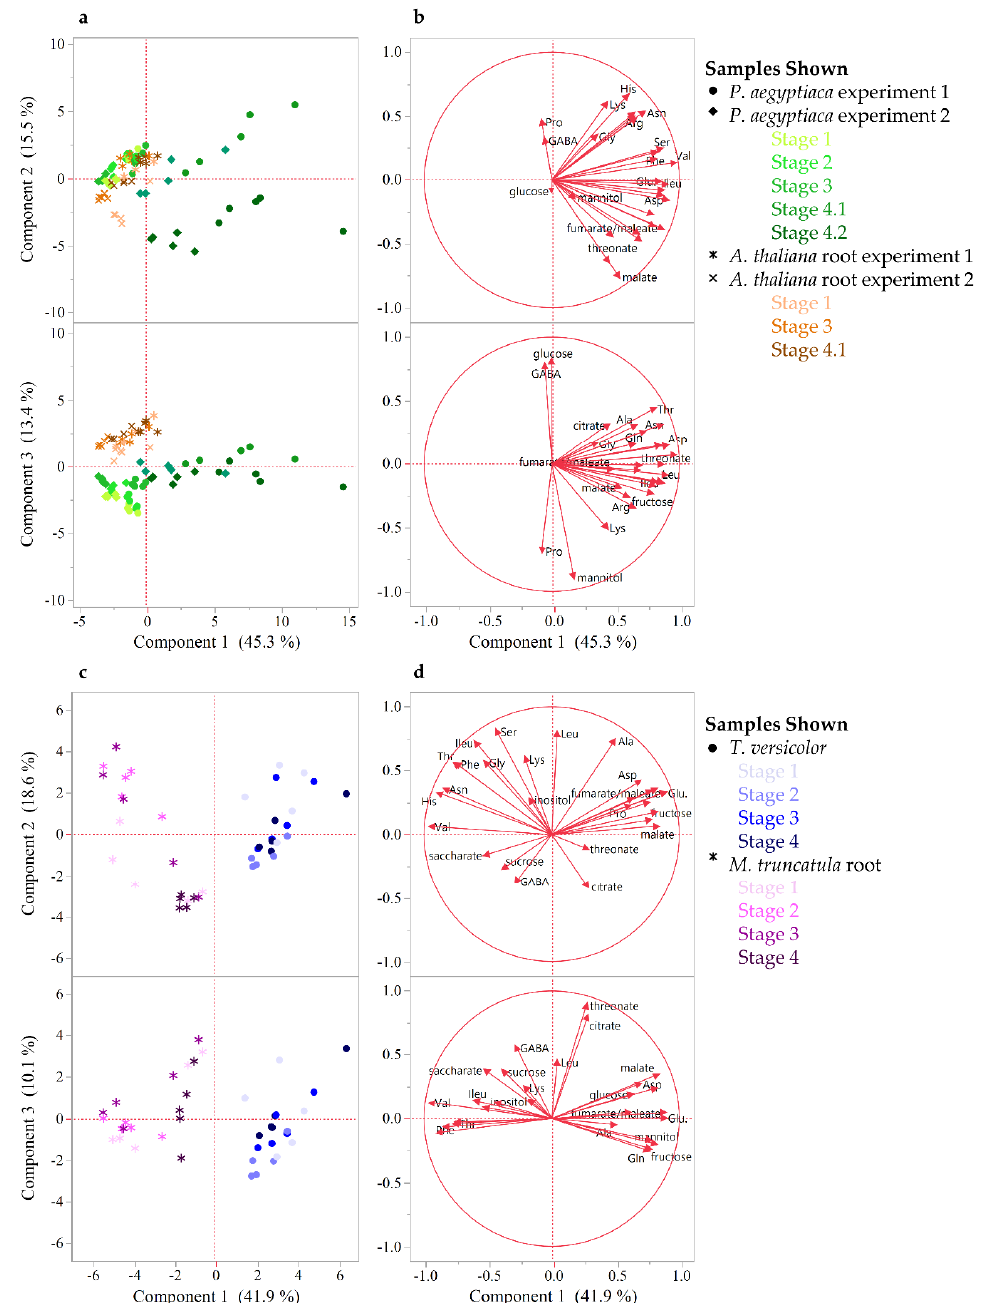
Figure 3. Metabolite profile comparison between developmental stages for host and parasite. ( a , b ) PCA on P. aegyptiaca and host metabolite level correlations. PCA was performed on combined data from two experiments with five stages of P. aegyptiaca and three stages of A. thaliana host root samples. The first three PCs are shown and together account for 74% of the variation between samples. ( c , d ) PCA on T. versicolor and host M. truncatula metabolite level correlations. The first three PCs are shown and together account for 71% of the variation between samples. ( a,c ) Score plots illustrate the separation between samples. ( b,d ) The loading plots illustrate the variables that account for the separation between samples. The data used relative or absolute levels of sugars and FAAs, respectively, and included four to five biological replicates per developmental stage.